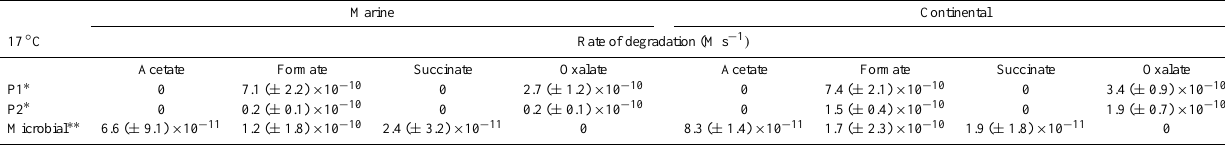
Table 3. Estimated rates of photo- and bio-degradation in artificial cloud water at 17 ◦ C. Marine